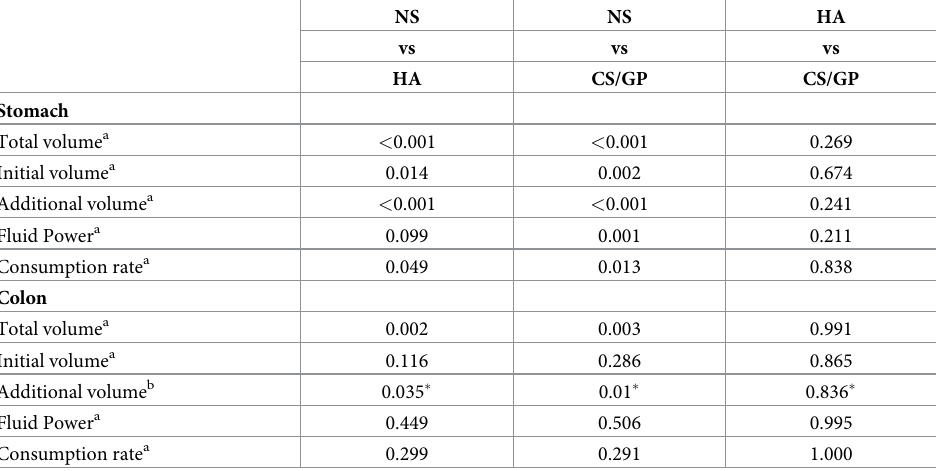
Table 3. Post hoc analysis of endoscopic submucosal dissection parameters.